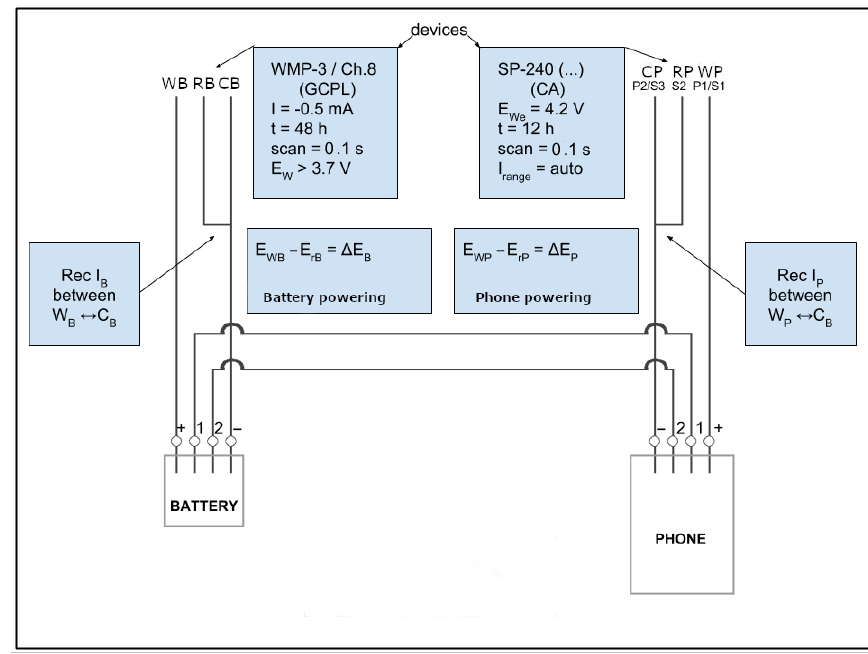
Figure 3. Circuit schema used to collect time and energy consumption